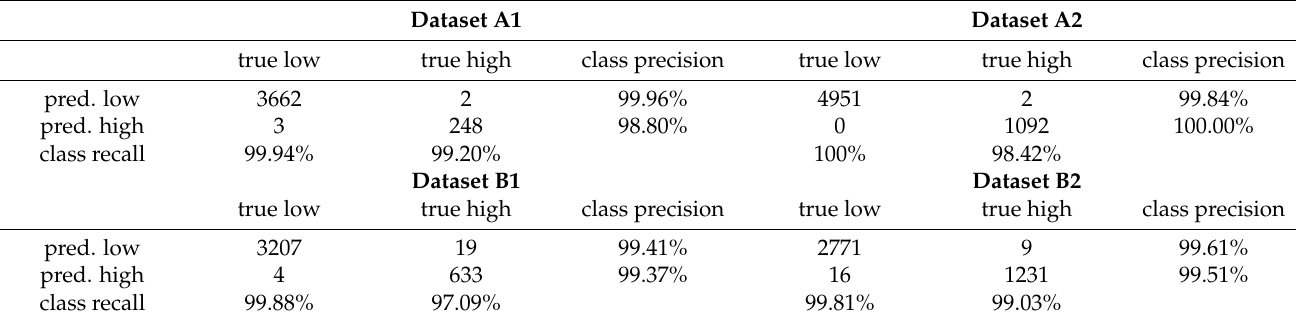
Table 7. Confusion matrix with the classification generated using ANN. This table shows the classification obtained with labels “low” and “high”, using datasets A1, A2, B1, and B2. Table 7 also shows the accuracy, recall, and class-precision values for both